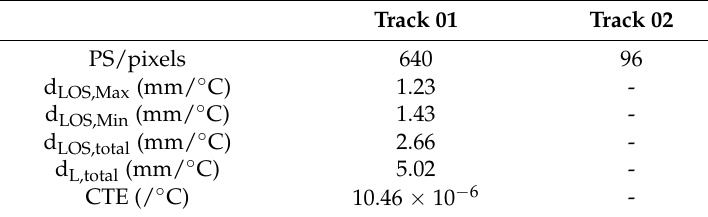
Figure 12. LOS phase components of the NYRB, estimated with Track 01 (upper) and Track 02 (lower); the reference point is marked with the red triangle, ( a ) thermal dilation coefficient, ( b ) topography error, and ( c ) linear velocity. Table 5. Thermal dilation parameters of the NYRB at the middle